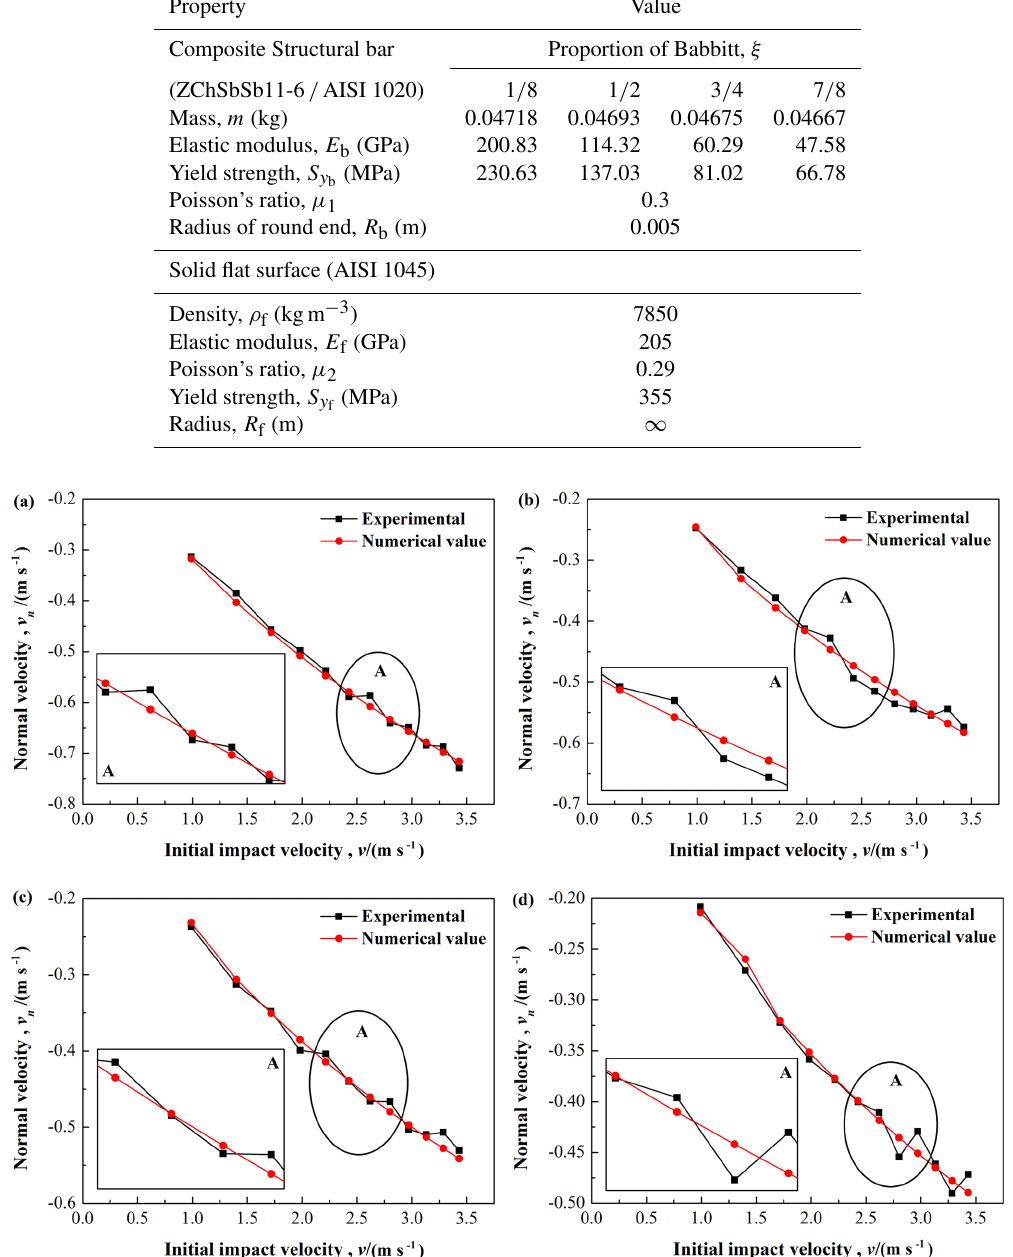
Figure 13. Comparison between the simulations and the experimental results for the rebound normal velocity: (a) ξ = 1 / 8, (b) ξ = 1 / 2, (c) ξ = 3 / 4, and (d) ξ = 7 /